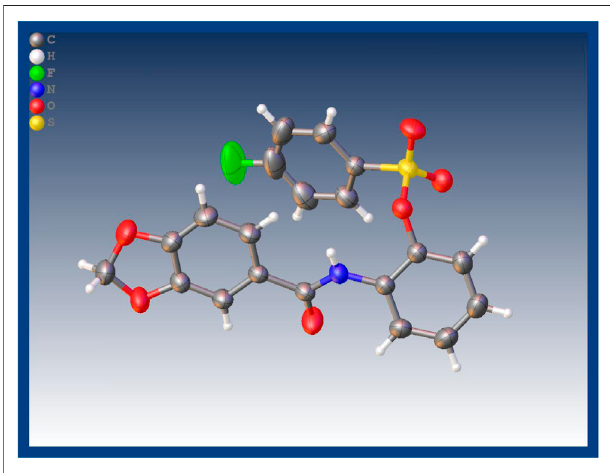
FIGURE 1 | X-ray crystal structure of compound 4a